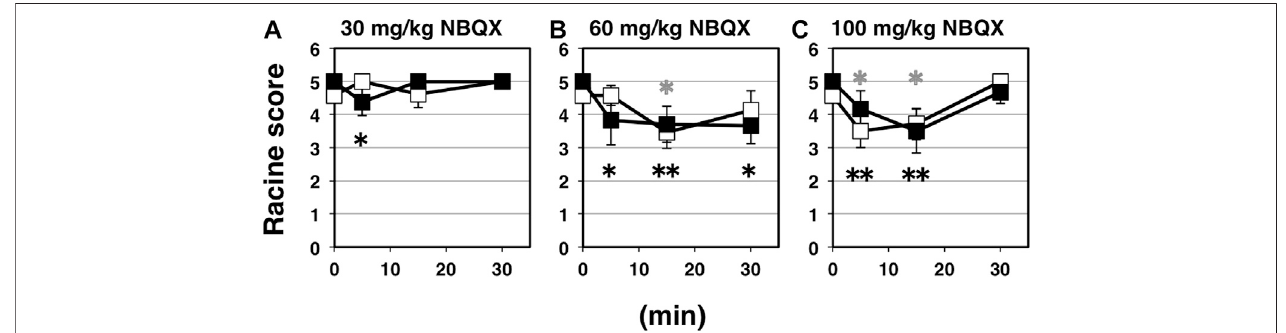
FIGURE 3 | Inhibitory effects of NBQX on PTZ-evoked seizure. (A) Time course of NBQX effects at doses of 30 mg/kg. Seizure scores of 7 weeks old male wild- type(whitesquares)andGluA1C811S(blacksquares)micereceivedanadministrationofNBQXatadoseof0or30 mg/kgforindicatedperiodsbeforeasingleinjection of 60 mg/kg PTZ. Four white squares (wt): n (cid:1) 19, 6, 5, 4 mice, four black squares [GluA1C811S]: n (cid:1) 19, 8, 4, 4 mice (left to right). (B) Time course of NBQX effects at doses of60 mg/kg.Seizure scores of 7 weeks old male wild-type (white squares) and GluA1C811S (black squares) mice received an administration ofNBQX at a dose of 0 or 60 mg/kg for indicated periods before a single injection of 60 mg/kg PTZ. Four white squares (wt): n (cid:1) 19, 7, 11, 8 mice, four black squares [GluA1C811S]: n (cid:1) 19, 6, 10, 9 mice (left to right). (C) Time course of NBQX effects at doses of 100 mg/kg. Seizure scores of 7 weeks old male wild-type (white squares) and GluA1C811S(blacksquares)micereceivedanadministration ofNBQXatadoseof0or100 mg/kg forindicatedperiods beforeasingle injectionof60 mg/kgPTZ. Four white squares (wt): n (cid:1) 19, 6, 7, 3 mice, four black squares [GluA1C811S]: n (cid:1) 19, 6, 6, 3 mice (left to right). Error bars represent s.e.m. ANOVA with Fisher ’ s LSD post hoc test. * p < 0.05, ** p < 0.01, compared to PBS controls. Colorless asterisks indicate wild-type and black asterisks indicate GluA1C811S